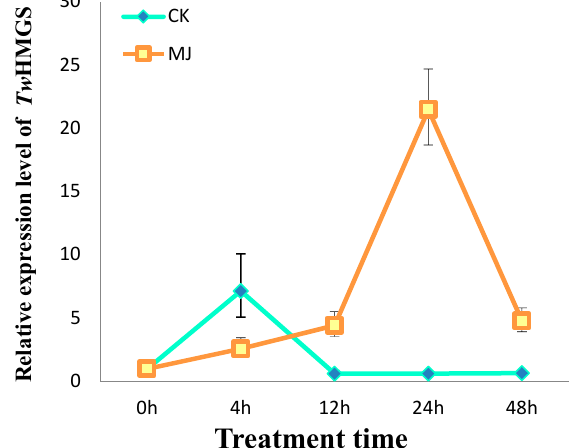
Figure 5. Expression levels of TwHMGS in suspension cells after MeJA treatment.